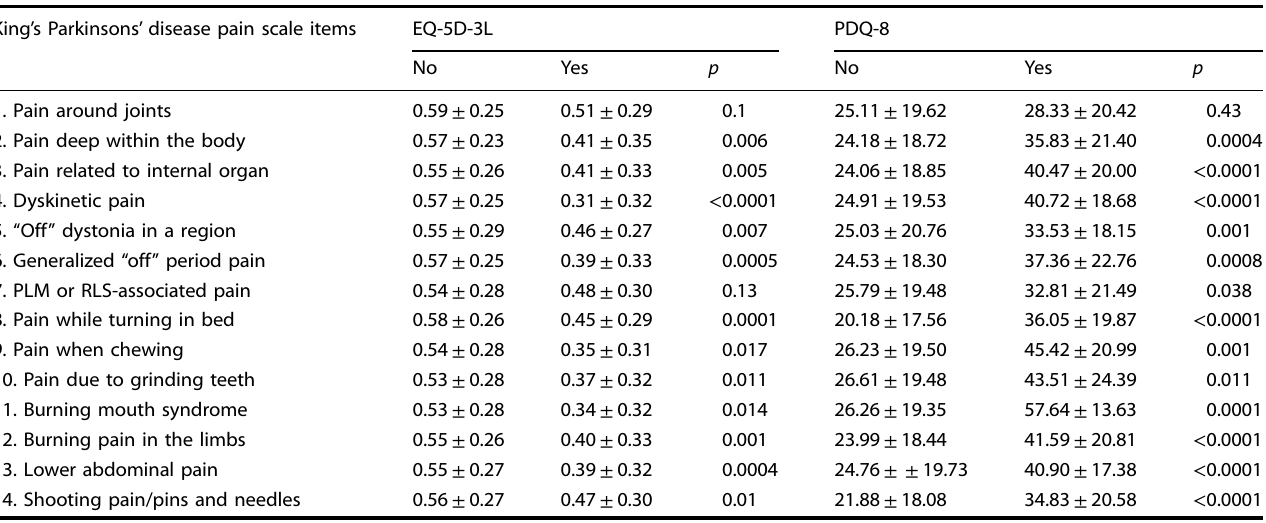
Table 3. Types of pain and quality of life indexes in Parkinson ’ s disease patients King ’ s Parkinsons ’ disease pain scale items